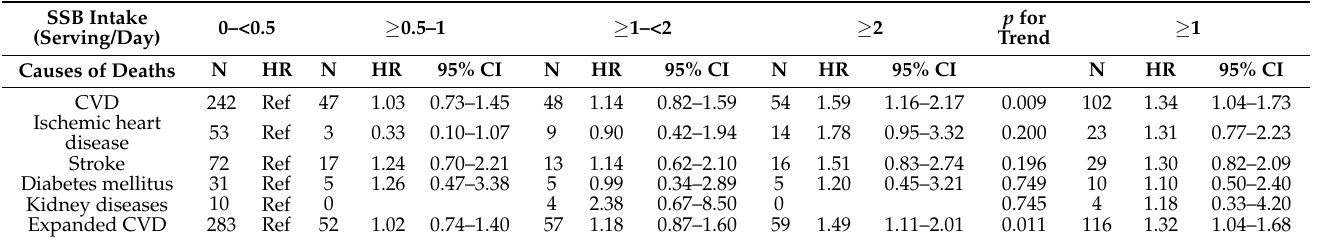
Table 2. The mortality risk of cardiovascular diseases by levels of sugar-sweetened beverages consumed in younger